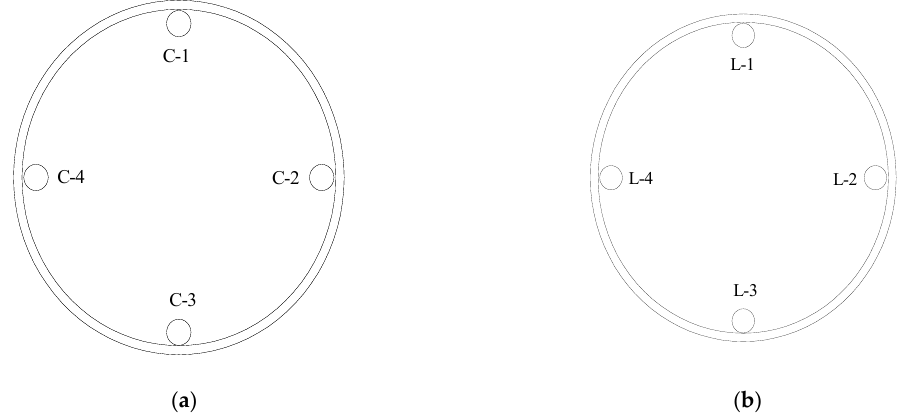
Figure 11. Diagram of strain measuring points: ( a ) Circumferential strain meter; ( b ) Longitudinal strain meter.